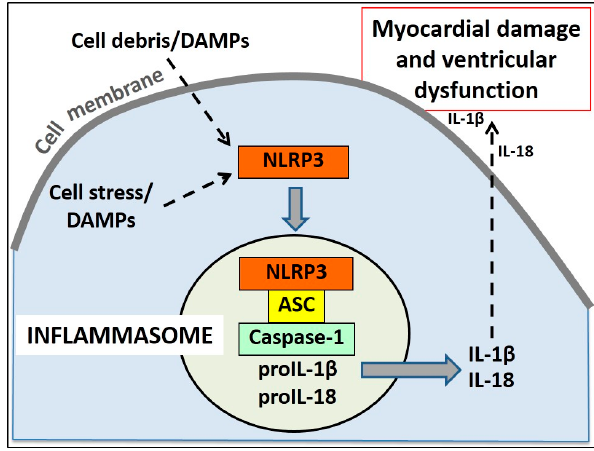
Figure 4. Schematic representation of the signaling pathway of the NOD-like receptors (NLR) containing a Pyrin Domain 3 (NLRP3) inflammasome following myocardial ischemic injury. Extracellular debris and intracellular stress signals activate the “danger sensor” NLRP3. NLRP3 recruits the adaptor protein ASC and the effector enzyme caspase-1. Caspase-1 converts the pro-forms of IL-1 β and IL-18 into the biologically active forms, which are released into the interstitial space. In severe cases, the persistent inflammasome activity induces cell death. The release of active IL-1 β and IL-18 induces further myocardial damage and ventricular dysfunction.